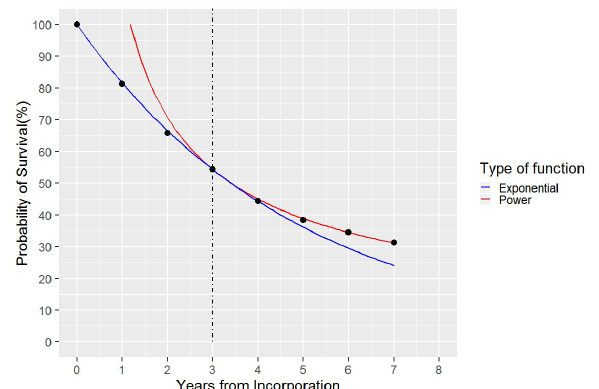
Figure 2: Probability of survival for the total for all